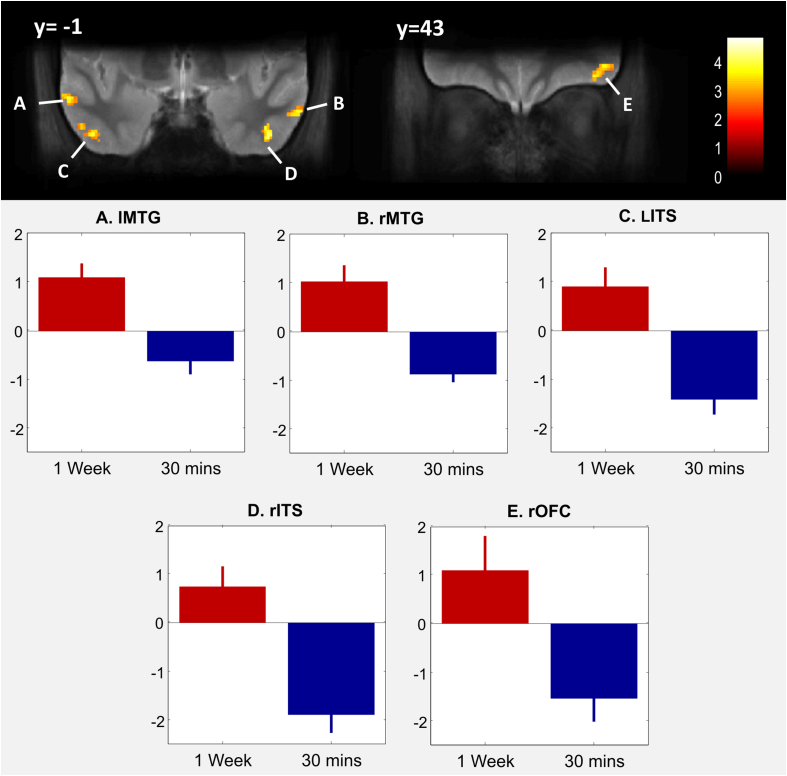
Response to 1-week scene recall relative to 30-min scene recall. SPM whole-volume analysis testing for regions responding more strongly to recalling scenes from one week earlier than scenes from 30 min earlier, controlling for object baselines [(1-week Scenes-Objects) − (30-Min Scenes-Objects)], i.e. an interaction between stimulus and task. Top. Coronal slices showing clusters of activations in lateral temporal cortex relating to this interaction. Labels correspond to plots below. Images thresholded at p < 0.05 FDR-corrected, overlaid on the group average T2 structural volume. Bottom. Parameter estimates averaged over voxels in the corresponding clusters, describing the interaction in each region. Red bars show 1-week scene recall [(1-Week Scenes-Objects)] and blue bars show 30-min scene recall [(30-Min Scenes-Objects)]. Positive values indicate a stronger response to scenes than object baselines. lMTG = left middle temporal gyrus, rMTG = right middle temporal gyrus, LITS = left inferior temporal sulcus, rITS = right inferior temporal sulcus, rOFC = right orbitofrontal cortex. ±1 SEM.